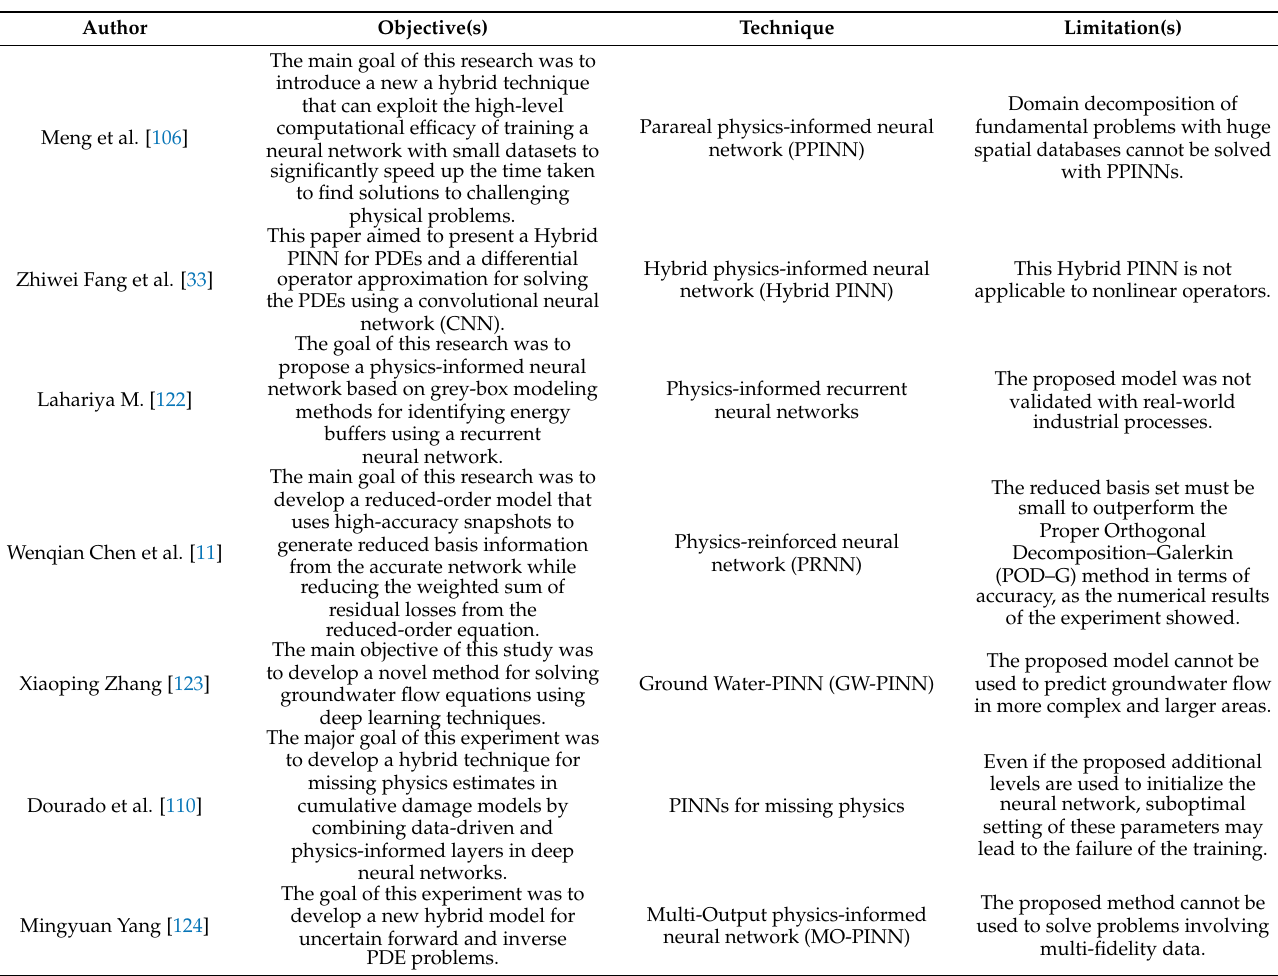
Table 4. Proposed Hybrid